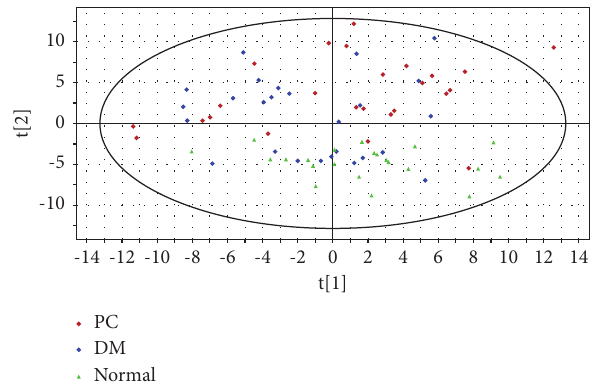
Figure 2: PCA scores of plasma metabolic profiles in PC, DM, and normal groups, suggesting good analytical stability and reliability of the UPLC-MS/MS workflow, as well as the plasma metabolite profile. t [1]: the first principal component; t[2]: the second prin- cipal component.